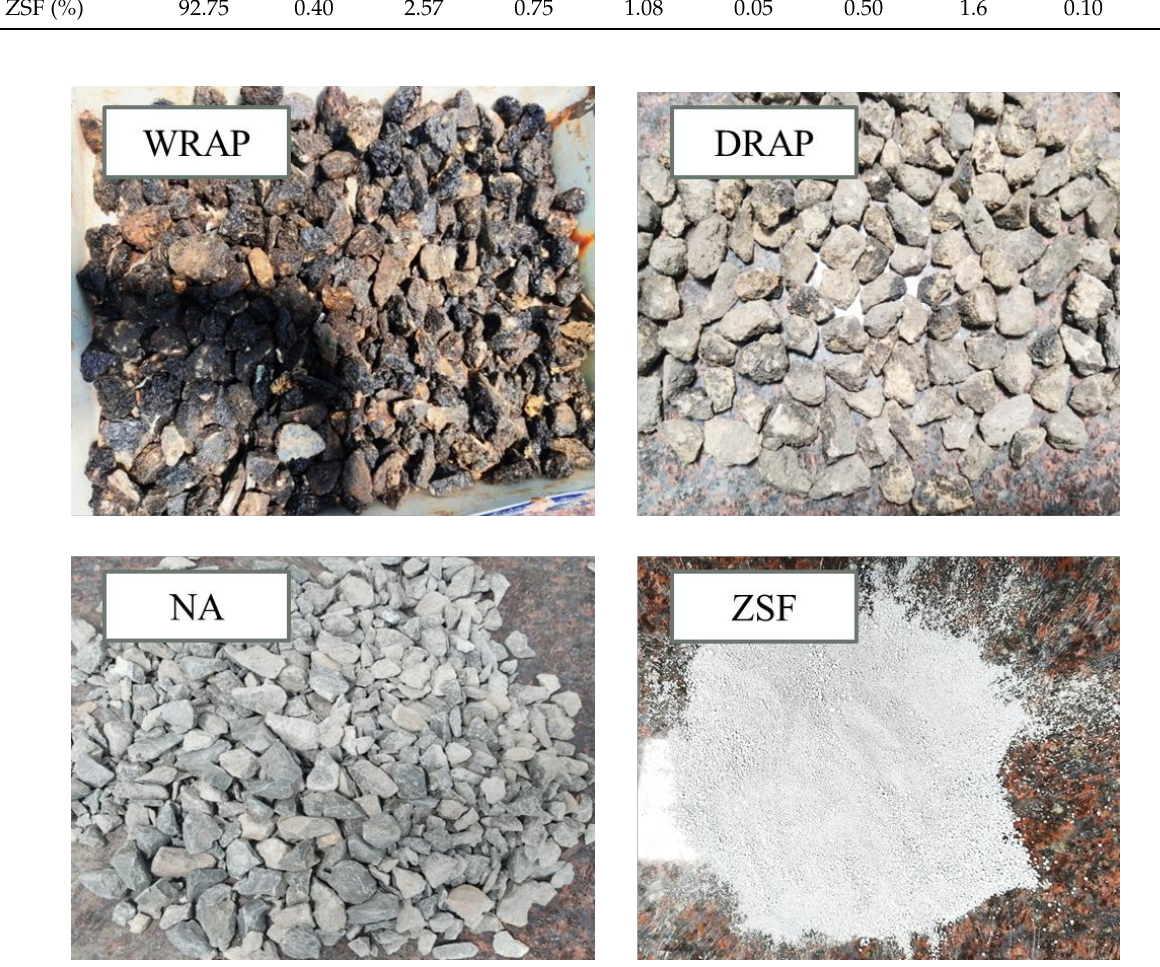
Figure 2. Collection of DRAP, WRAP, NA aggregates and ZSF admixtures used in the present study. Concrete mixtures containing varying amounts of locally available industrial waste i.e., Zirconia silica fumes (ZSF) were added in different proportions. The considered ad- mixtures, whose specific gravity and surface area were 2.3 and 18,500 cm 2 /g respectively (mentioned in Table 1). Figure 3 depicts grain size distribution curves of virgin, DRAP, and WRAP aggregates in compliance with IS: 383-1970 [62]. The grading curve represents the cumulative percentages of sieve passage as ordinated to the logarithm scale as ab- scissa. The ZSF admixture is derived from Zirconia compounds by a fusion process in the and characterized by a particle size of less than 1 micron for the present study. Potable chemical compositions of cement and ZSF admixtures are tabulated in Table 1 from the X-ray fluorescence (XRF)